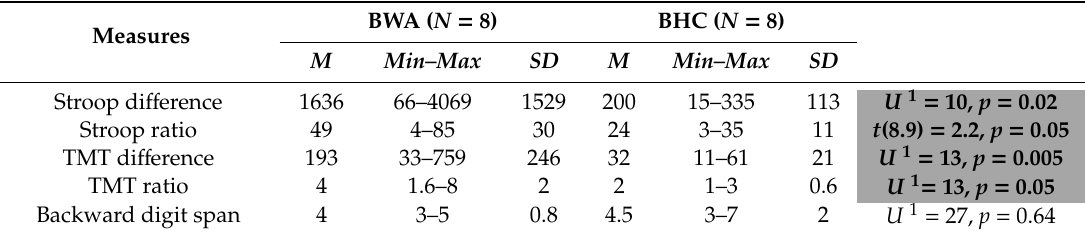
Table 4. Means, standard deviations, and the statistical results of the executive control measures by group (BWA; BHC).